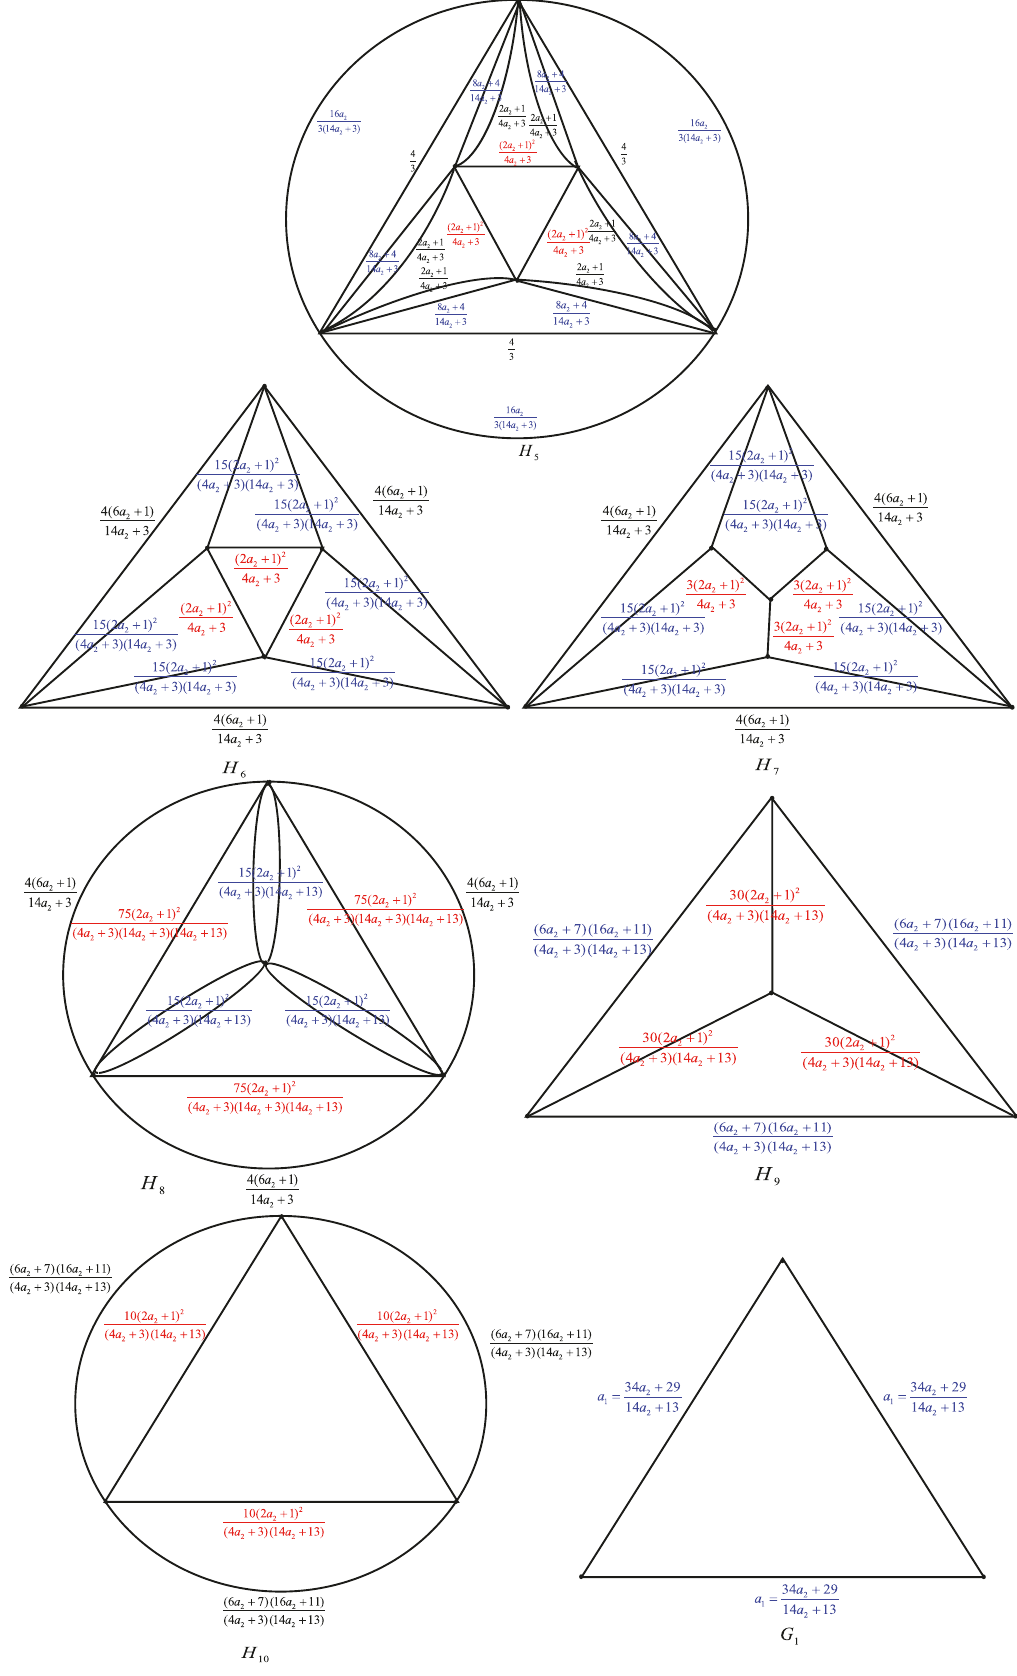
Figure 2: The transformations from 𝐺 2 to 𝐺 1